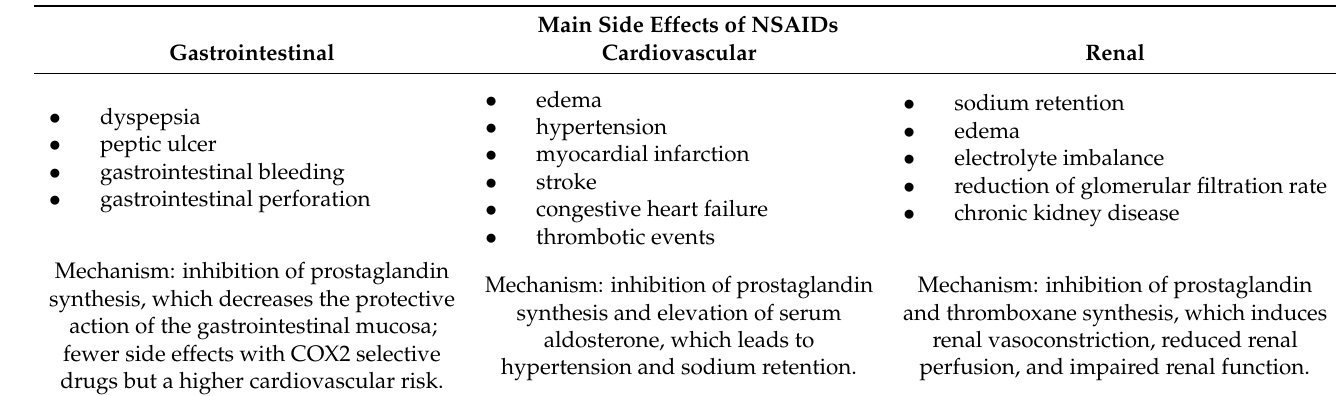
Table 7. Main side effects of NSAIDs